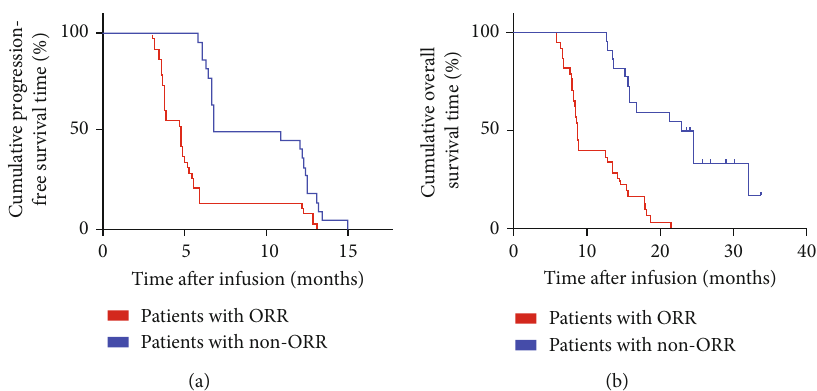
Figure 5: Kaplan-Meier curves for PFS and OS of patients with ORR (CR+PR), N = 22 , and non-ORR, N = 38 . (a) The PFS curve of patients with ORR and non-ORR. (b) The OS curve of patients with ORR and non-ORR. The blue line shows patients with ORR, and the red line shows patients with